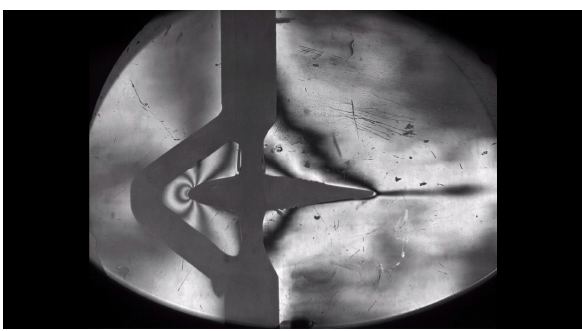
Fig. 11. Relationship between Strouhal and Mach number.